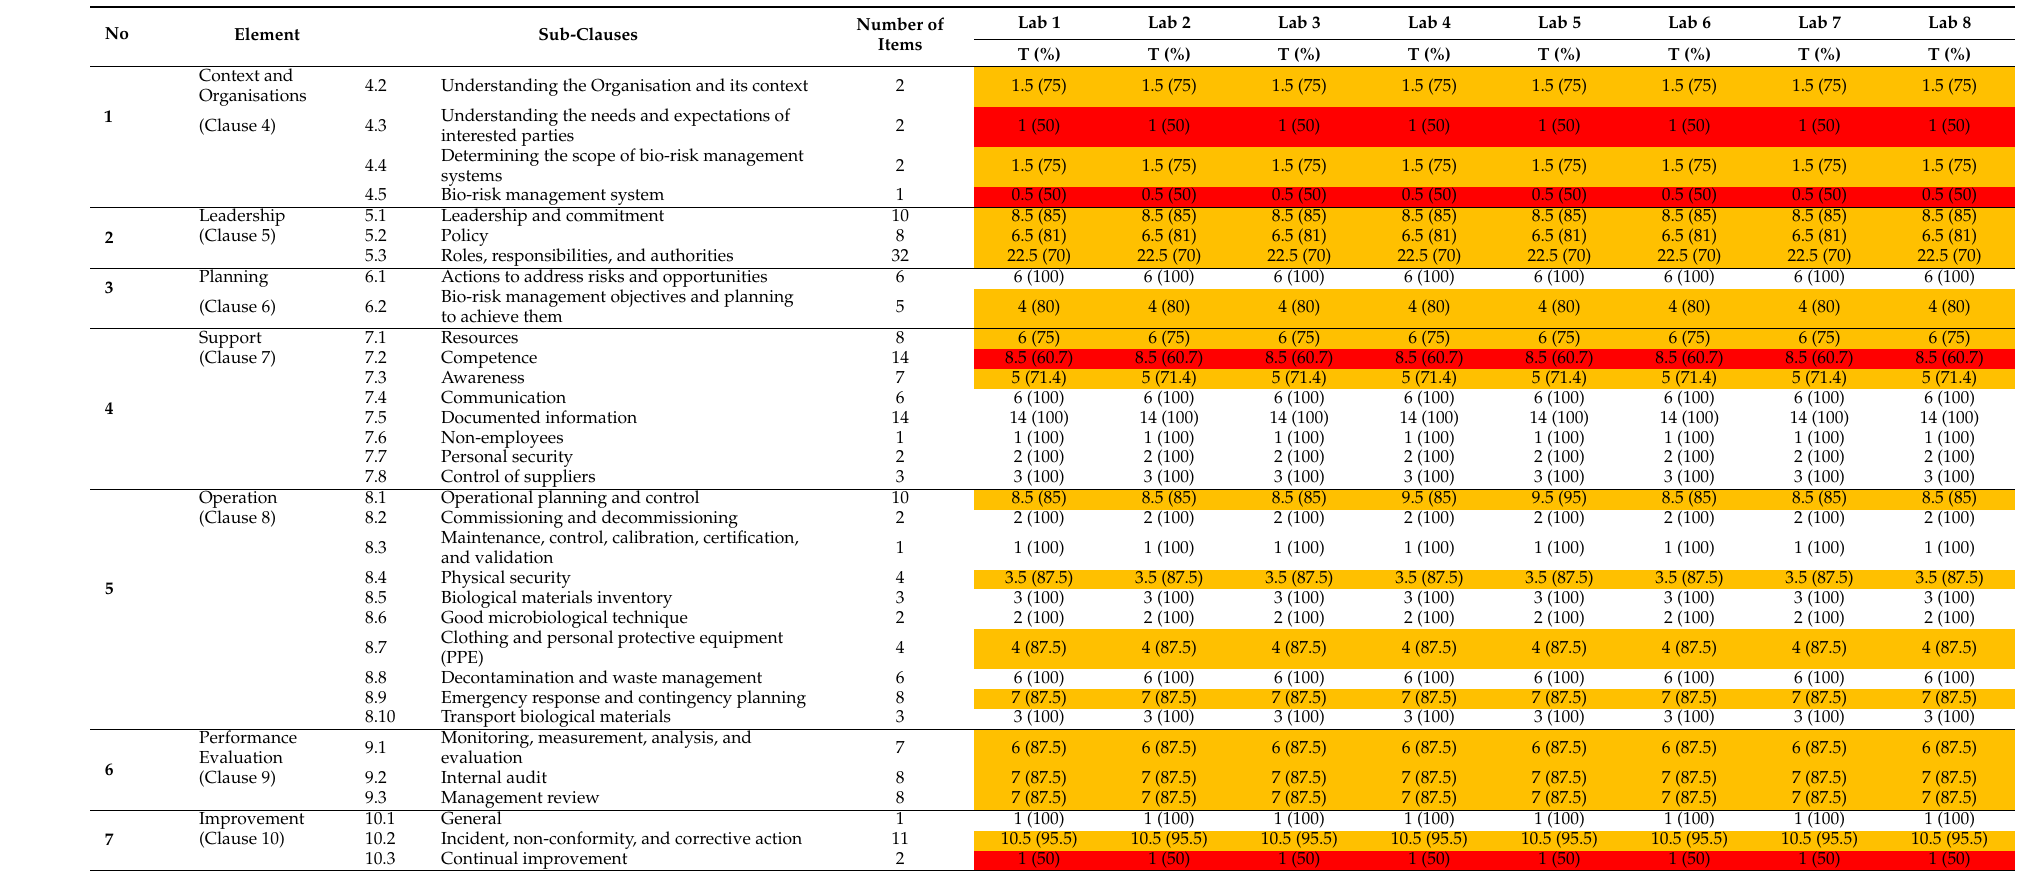
Table 3. Total implementation score (T) by